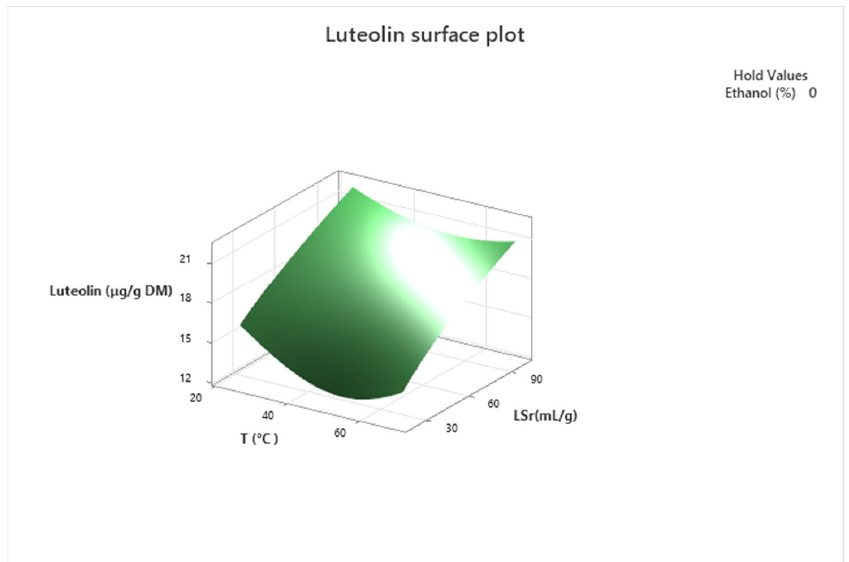
Figure 6. 3D response surface plot of luteolin (response variable) in μ g/g of dry matter (DM) of parsley as a function of Temperature (X 1 ) in Celsius degrees (°C) and ratio of solvent to dry parsley (LSr) in ml/g while holding ethanol at 0% ( v / v ).